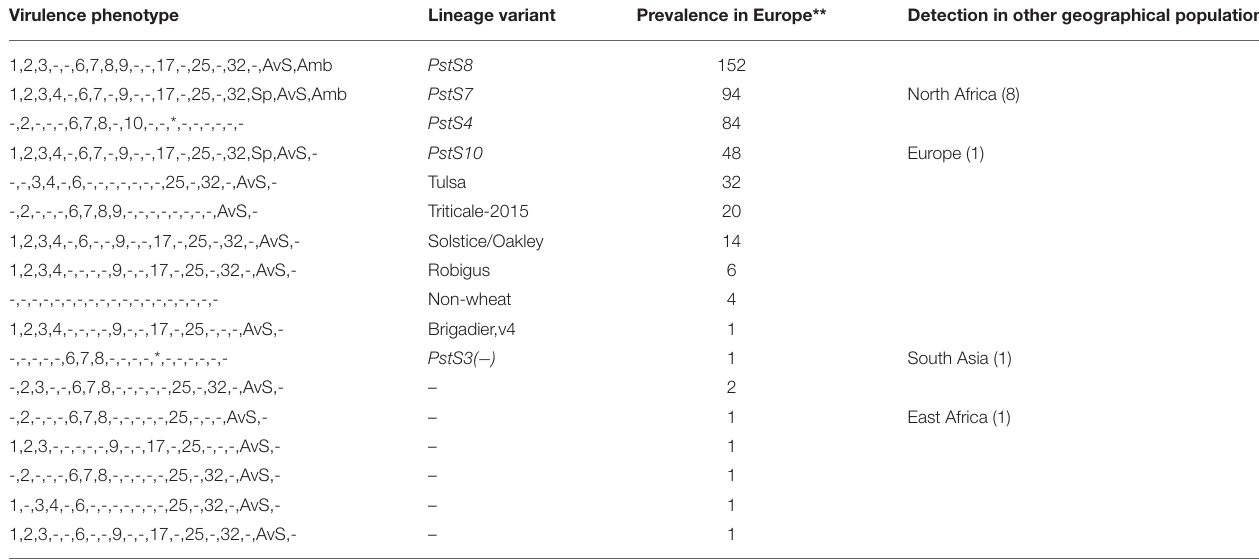
TABLE 4A | Prevalence of P. striiformis races detected in Europe during 2009–2015. Virulence